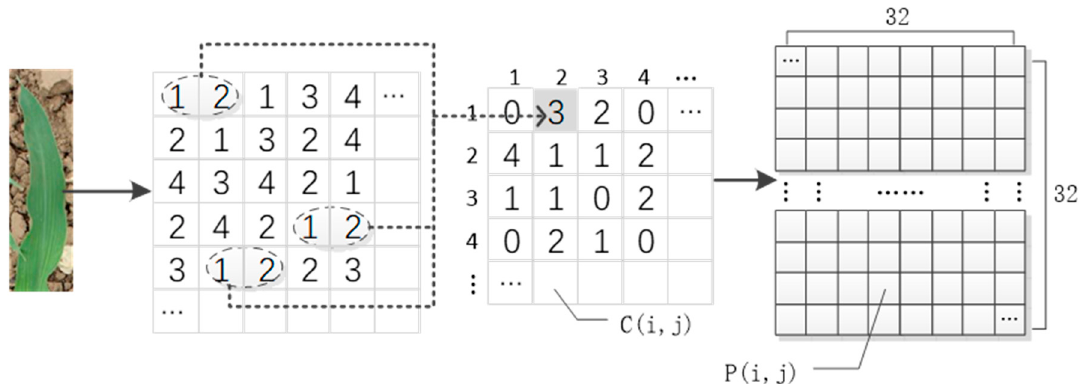
Figure 7. Generation process of gray level co-occurrence matrix.